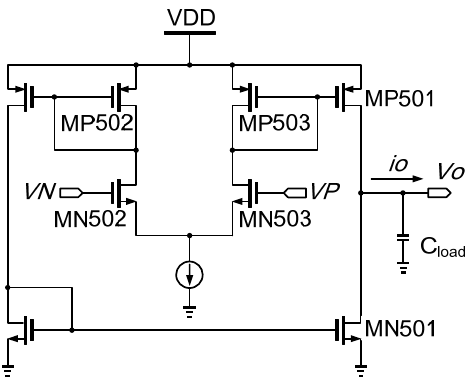
Figure 13. Schematic of the operational transconductance